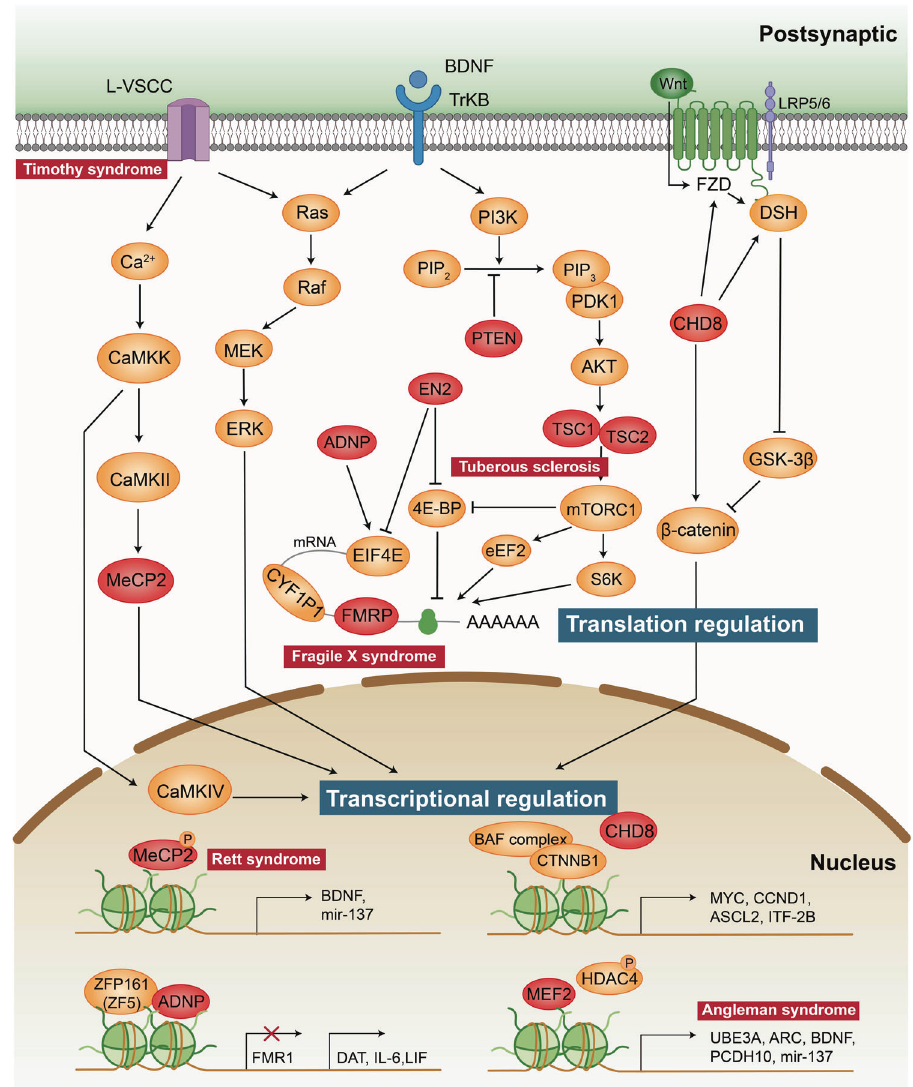
Fig. 3 Transcription factors and translation mechanism associated with ASD. Activity-regulated translational pathways including the Ras/ERK and PI3K/mTOR. Both of them could be activated upon the stimulation of TrKB. Activation of L-type voltage-sensitive calcium channels (L- VSCCs) triggers calcium in fl ux, induction of calcium-dependent signalling molecules and Ras/ERK pathways, involving in transcriptional regulation. These signalling cascades transcription regulators in the nucleus lead to the expression of transcription factors, thereby contributing to the regulation of activity-dependent gene transcription. Mutations of proteins involved in transcriptional regulation are associated with some syndromes of ASD, including L-VSCC in Timothy syndrome, MeCP2 in Rett syndrome and UBE3A in Angleman syndrome. Mutations of proteins involved in translation regulation including PTEN, ADNP, EN2, TSC1/TSC2 (tuberous sclerosis) and FMRP (fragile X syndrome). These genes have been highlighted in red Synaptic structure and homoeostasis . Intact synaptic structure PSD95, AMPA receptor and glutamate receptor 1 (GluR1), which is and homoeostasis are fundamental for the normal function of the critical for dendritic spine formation and synaptic transmis- brain. Neuropathological studies have provided evidence of sion. 186,187 increased dendritic spine density and aberrant dendritic spine NRXNs and NLGNs are presynaptic and postsynaptic binding morphology in individuals with ASD. 182,183 Moreover, reduced partners that cooperate to form transsynaptic complexes that developmental synaptic pruning in layer V pyramidal neurons in directly mediate synapse formation and stabilization but are the postmortem ASD temporal lobe has been shown to abnormally manifested during autism pathology. 61,176,188 Whereas hyperactive mTOR and defective autophagy. 146 At excitatory NLGN-1, NLGN-3 and NLGN-4 localize to the glutamate post- synapses, the molecular diversity of surface receptors impacts synaptic membrane, NLGN-2 localizes primarily to GABA proper synapse formation, maturation and transmission by synapses. 189,190 NLGNs can participate in the formation of organizing clustering of interaction partners at postsynaptic glutamatergic and GABAergic synapses in an activity-dependent regions. For example, the intracellular carboxy-terminal portions manner. 189 Speci fi cally, inhibition of NMDARs or the downstream of cell adhesion molecules (NLGNs) can bind to several scaffolding protein CaMKII suppresses the formation of glutamatergic proteins of the postsynaptic density, such as postsynaptic density synapses through the activity of NLGN1, whereas inhibition of protein 95 (PSD95) and SHANKs. 184,185 SHANK3 can interact with NLGN2 activity suppresses the formation of GABAergic Signal Transduction and Targeted Therapy (2022)